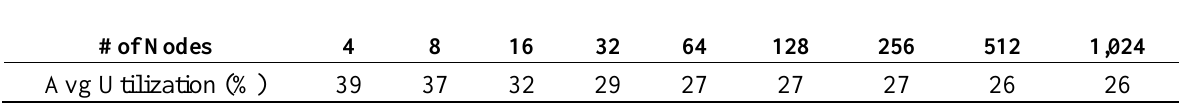
Table 1. The average utilization of quad cores during AvororaZ simulation via lock-step technique for synchronization (CountSend / CountReceive,